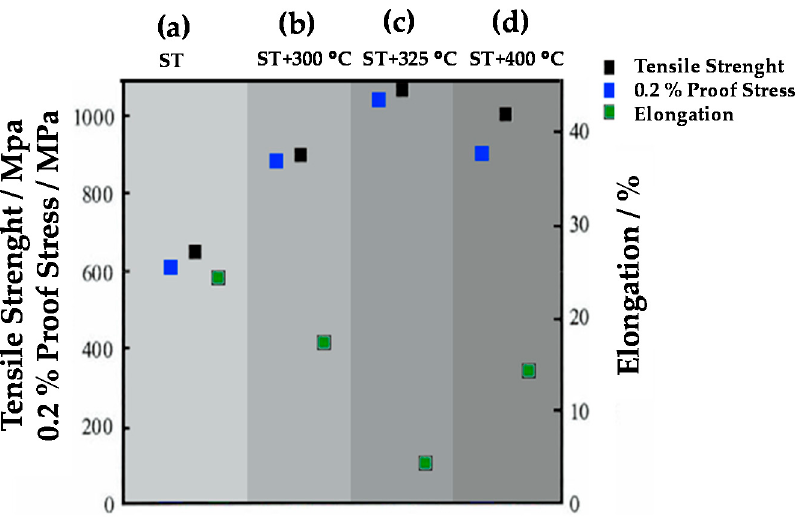
Figure 3. Tensile properties of TNTZ (Ti-29Nb-13Ta-4.6Zr) in a solution state ( a ) and after aging for 72 h at 300 °C ( b ), 325 °C ( c ), and 400 °C ( d ) [32,45].